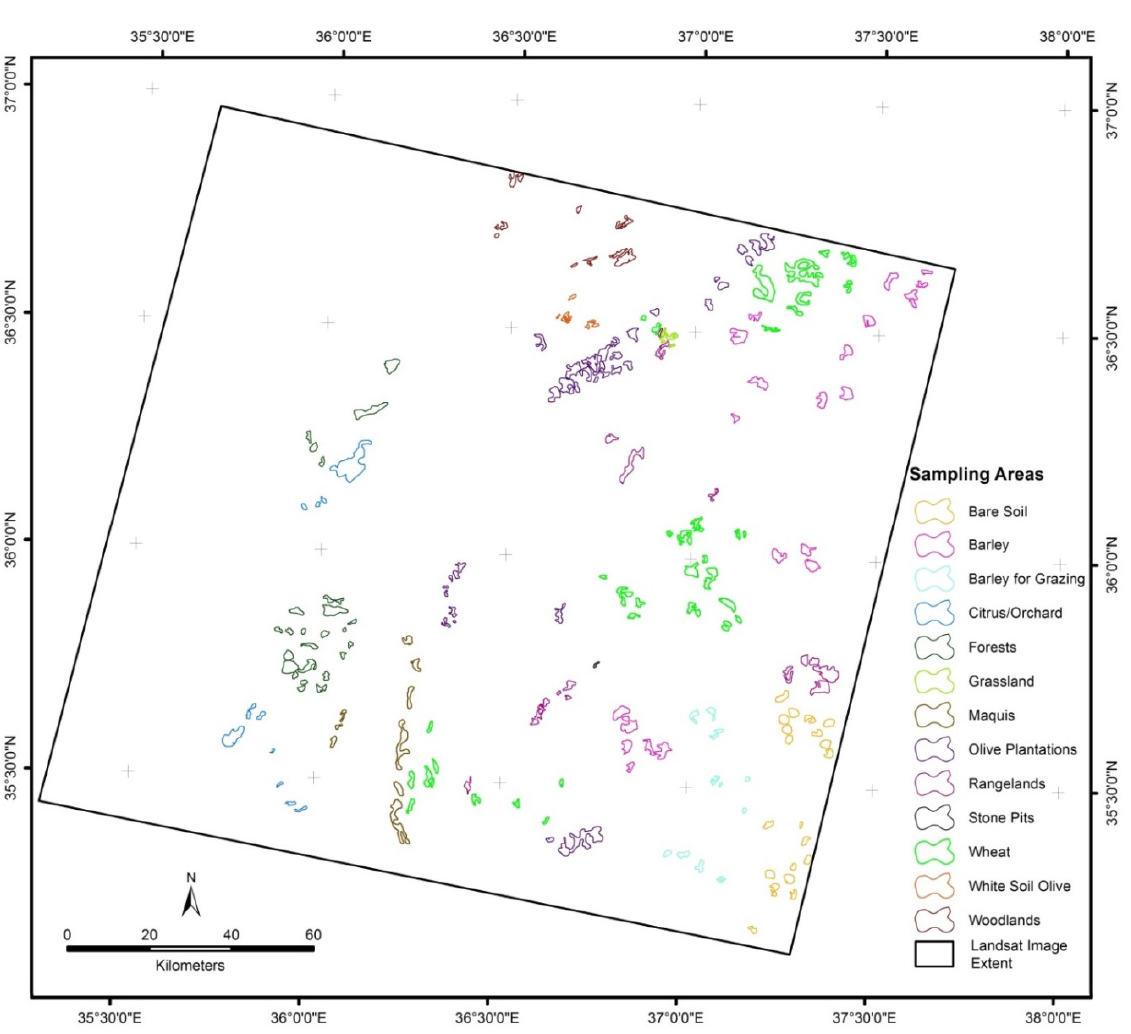
Figure 3. Distribution of the sampling areas taking the Landsat-MODIS image pair of 1 May 2007 as an